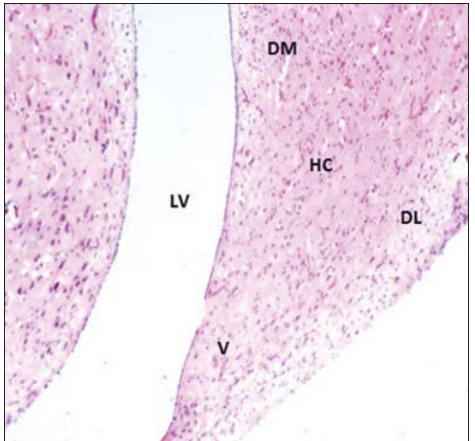
Figure-4: Cross section of hippocampus (HC) & adjacent Lateral Ventricle (LV) (H & E ×100). (DL) Dorso-lateral, (DM) Dorso-medial, (V)